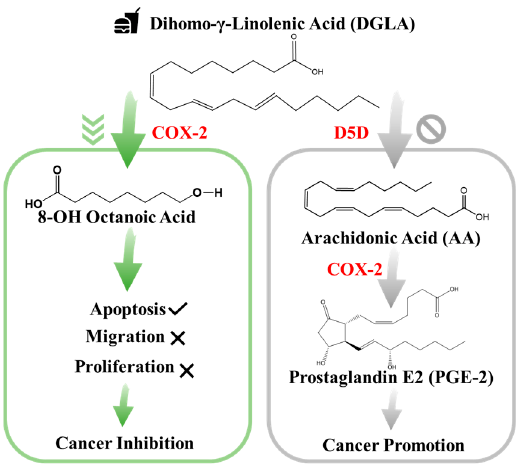
Figure 1. New anti-cancer strategy: target but do not inhibit cyclooxygenase-2 (COX-2) in cancer.